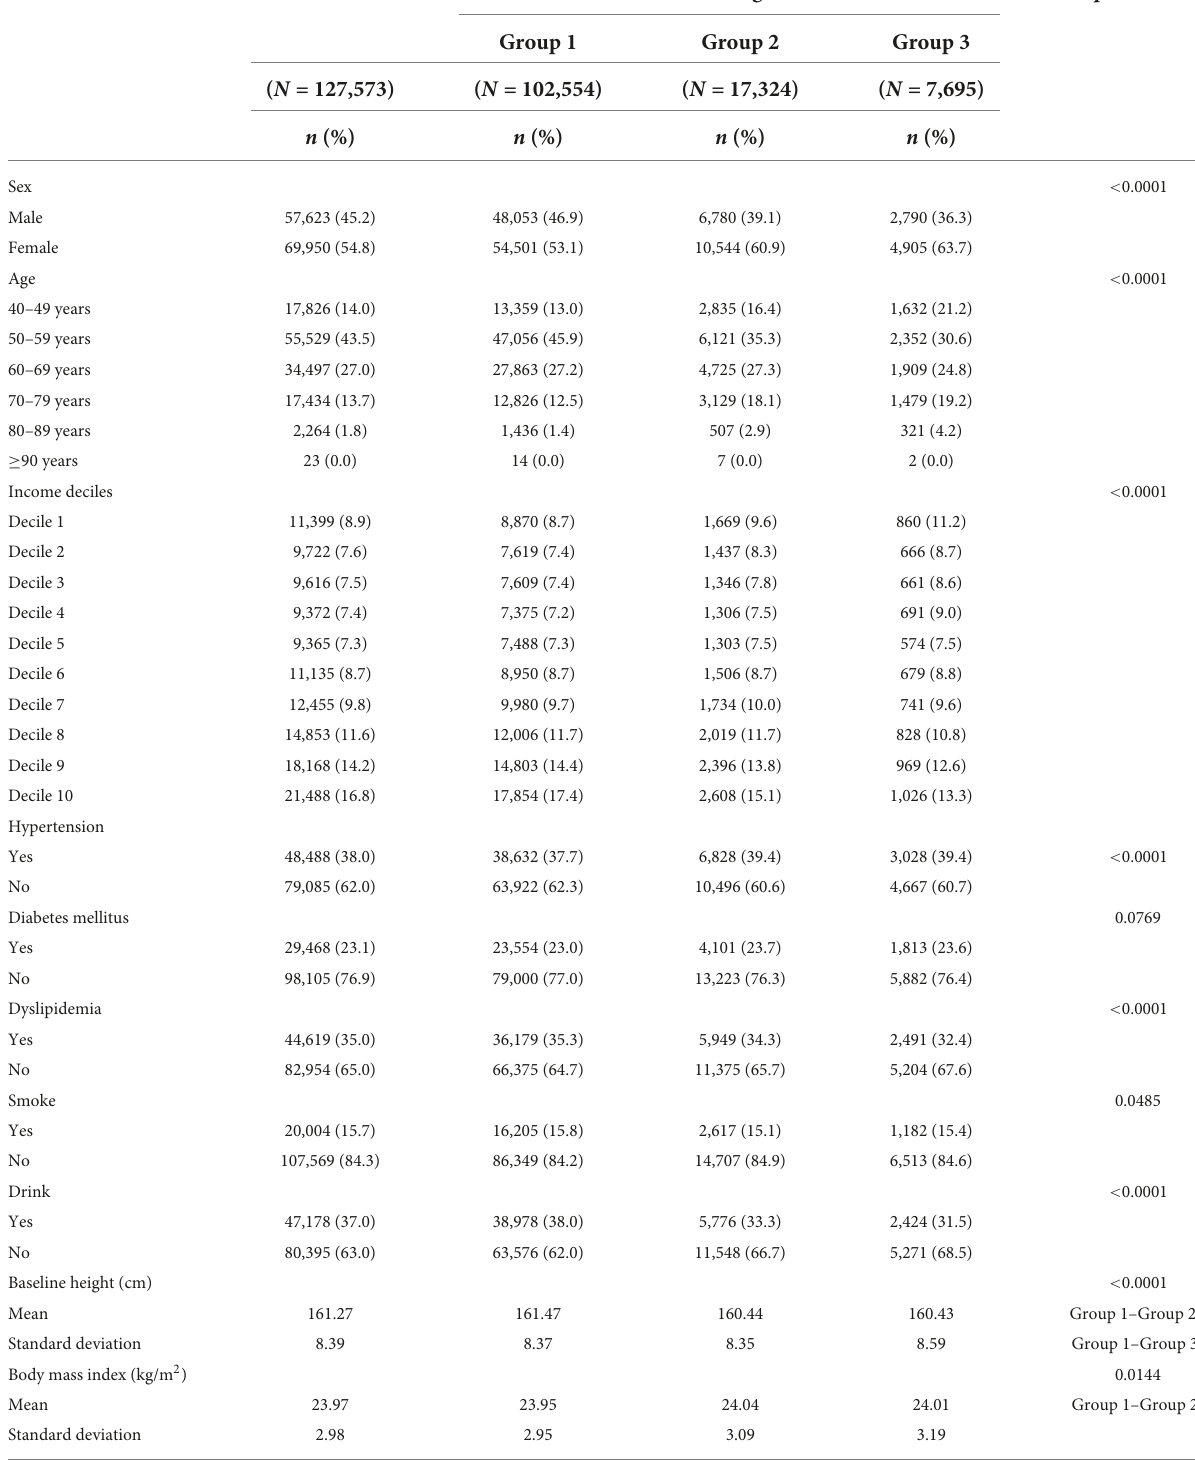
TABLE 1 Study population baseline